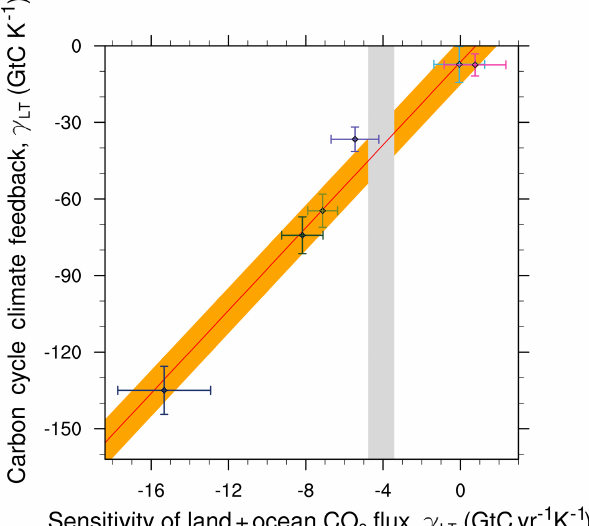
Figure 9. Relationship between long-term sensitivity of tropi- cal land carbon storage to climate warming ( γ LT ) and short-term sensitivity of atmospheric CO 2 to interannual temperature vari- ability ( γ IAV ) for CMIP5 models (markers with horizontal and vertical error bars) using the historical simulation. The red line shows the linear regression through the CMIP5 models; the ver- tical gray area shows the range of observed γ IAV . Produced with recipe_wenzel14jgr.yml , similar to Fig. 5a of Wenzel et al. (2014) (for details, see Sect.